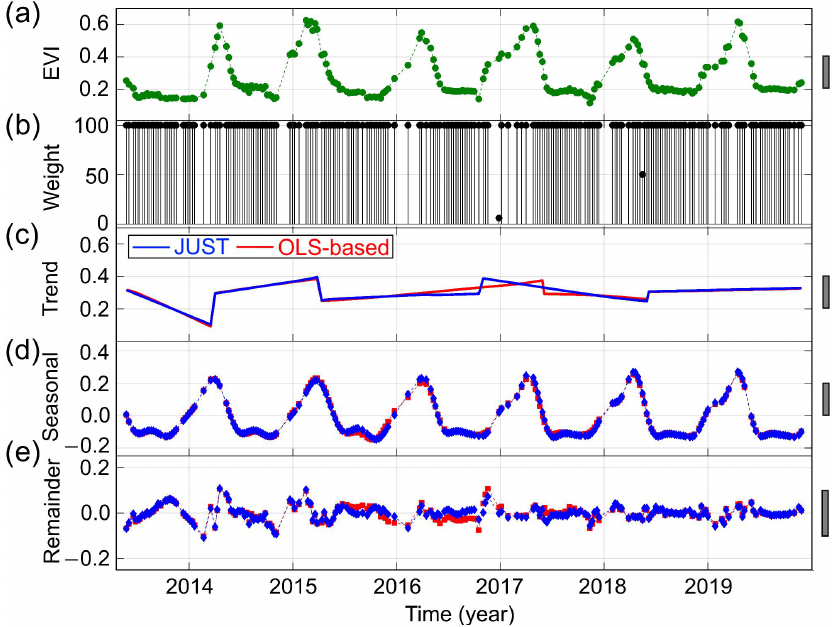
Figure 16. Decomposition results of the EVI time series corresponding to pixel C shown in Figure